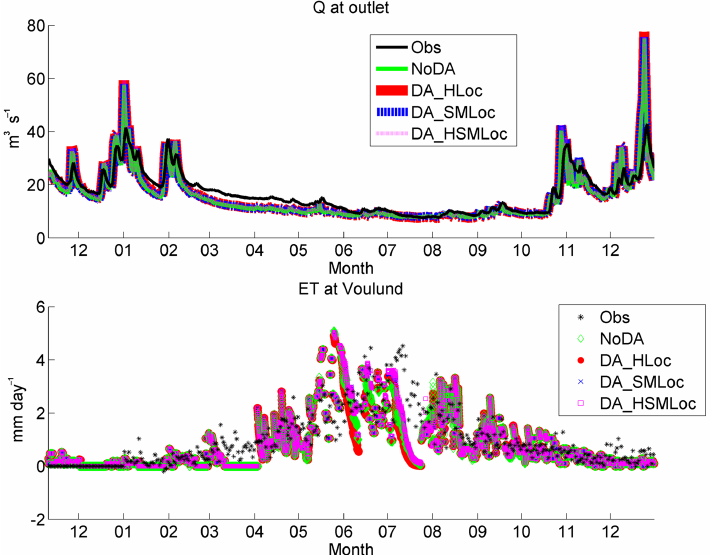
Figure 10. Top: discharge at the Ahlergaarde catchment outlet (station 250082) for each experiment and observed discharge. Bottom: actual evapotranspiration in each experiment and observed evapotranspiration at the observed station (Voulund) at Ahlergaarde